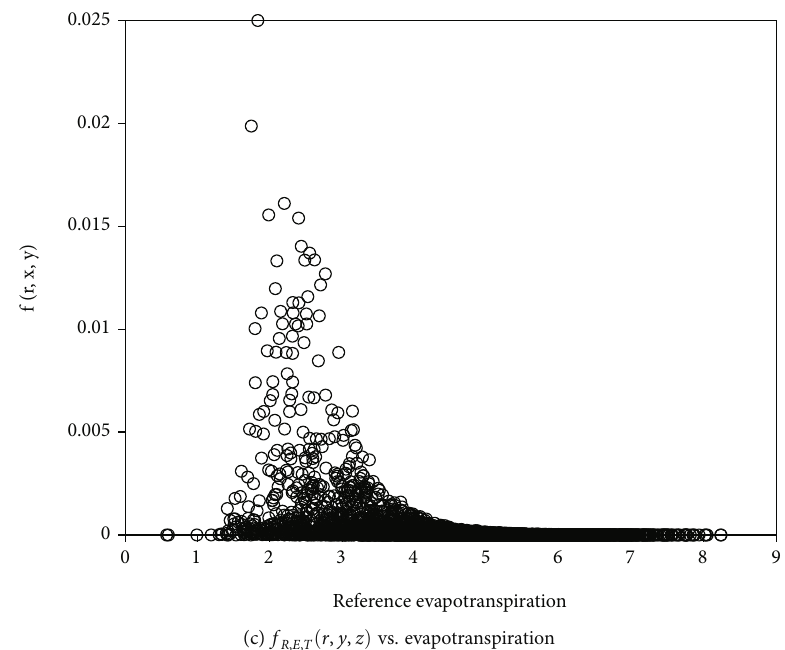
r , y , z Þ estimated from Frank Figure 9: f R , E , T ð